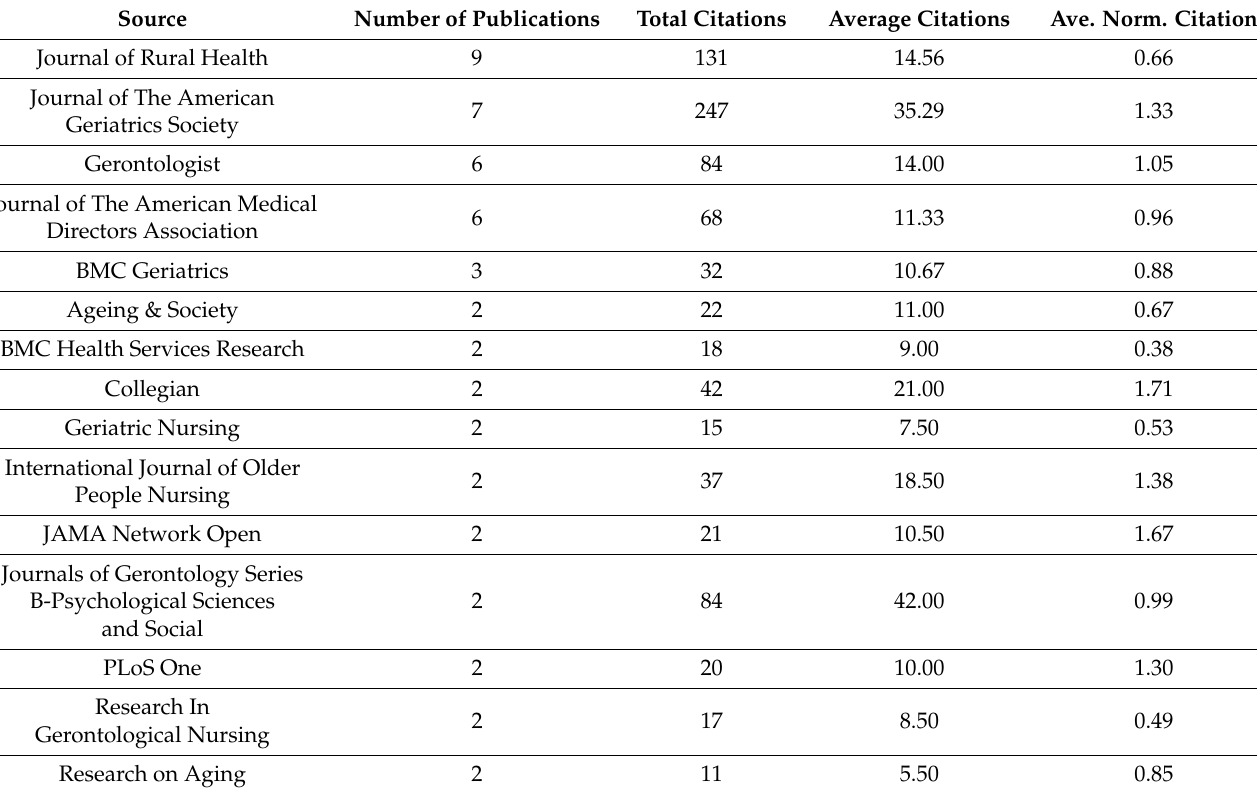
Figure 4. Map of mainstream journals in the field of rural institutional elder care. Table 1. Quantitative measurements of journals publishing rural institutional elder care